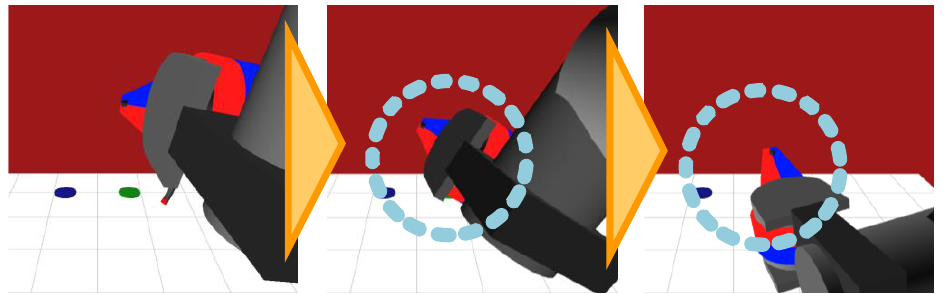
Figure 9. Hiding the tip of the needle during the suturing motion.